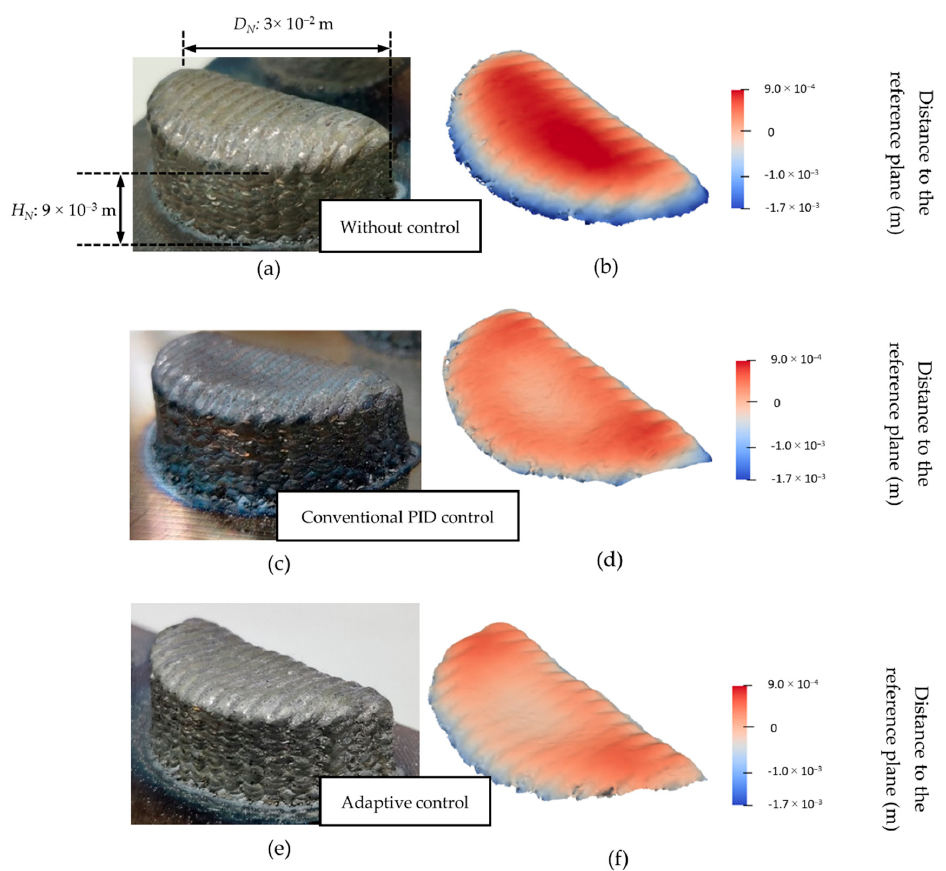
Figure 8. Samples of Experiment 2 (solid semicylinder without the profile tool path, 316 L stainless steel). ( a ) The sample fabricated without control; ( b ) The reconstructed surface of the uncontrolled sample; ( c ) The sample fabricated with conventional PID controller; ( d ) The reconstructed surface of the conventional PID controlled sample; ( e ) The sample fabricated with proposed adaptive control method; ( f ) The reconstructed surface of the adaptively controlled sample.